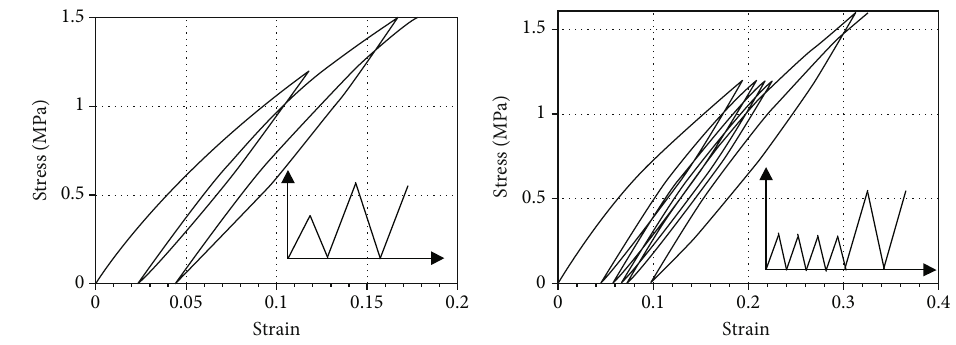
Figure 12: Typical stress-strain curves of the theoretical model.